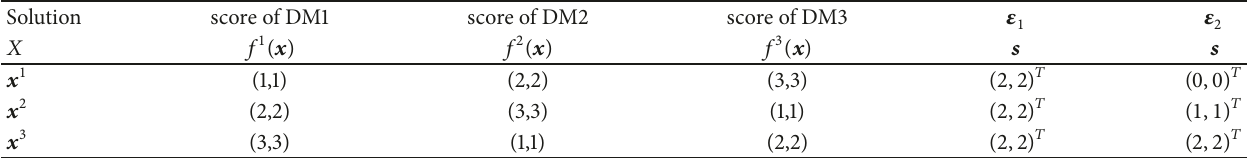
Table 1: The score of three decisions and the equilibrium value under different target concession values.